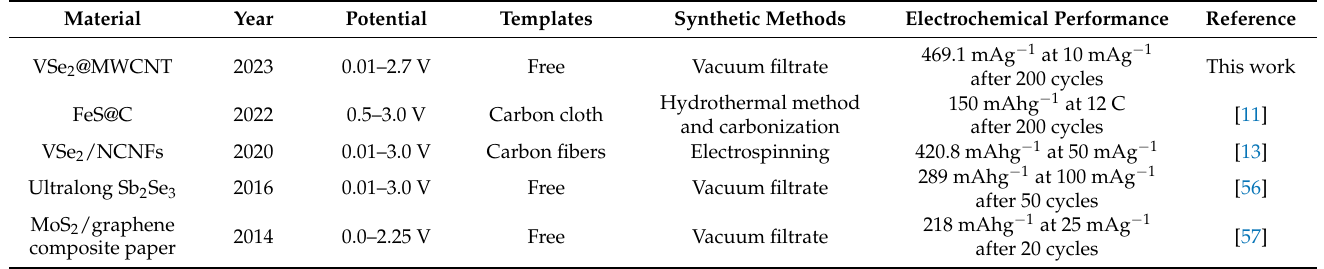
Table 1. Comparison of electrochemical performance of different kinds of binder-free electrode